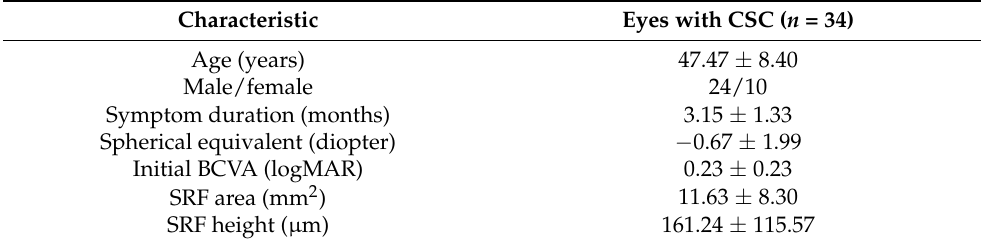
Table 1. Demographic and clinical characteristics of patients at baseline.